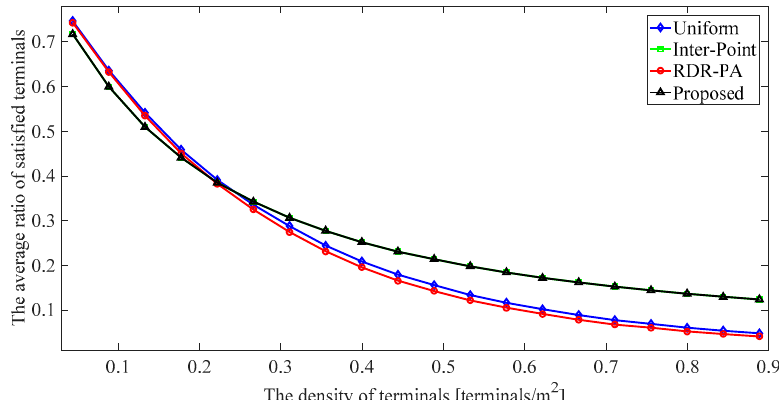
Figure 3. The average throughput per terminal versus the density of terminals.